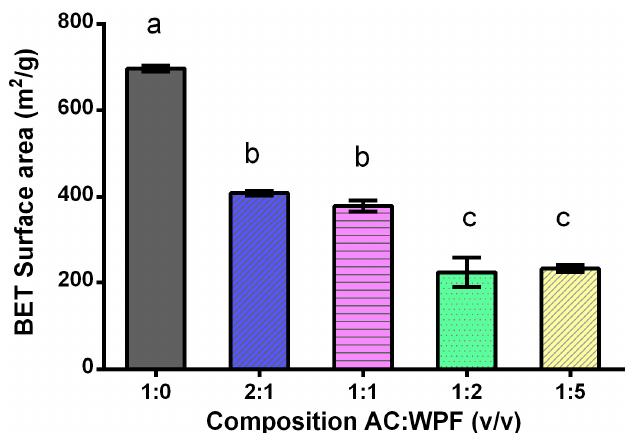
Figure 5. BET surface area of different mixtures of AC and WPF. Error bars are standard deviations ( n = 3). Different letters indicate significant differences between different treatments at p -level = 0.05 based on the least significant difference (LSD)